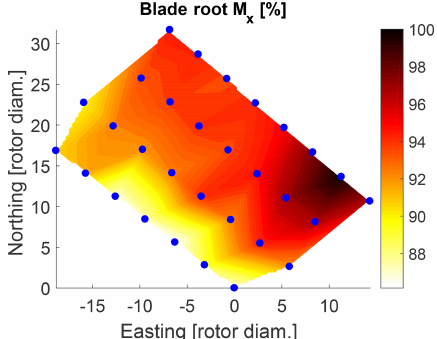
Figure 18. Estimated normalized blade-root flapwise DEL within wind farm for normal operation including start-up and shutdown